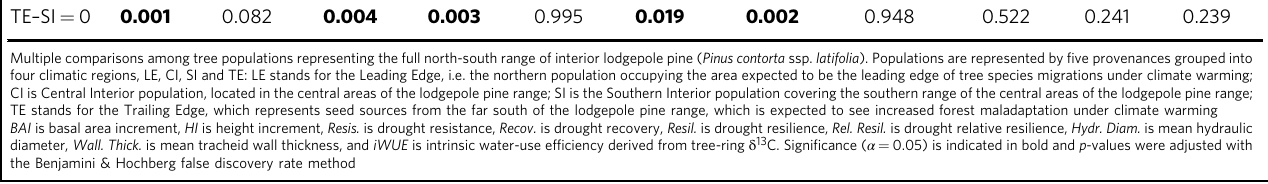
physiological parameters in Fig. 2. Higher productivity and mod-